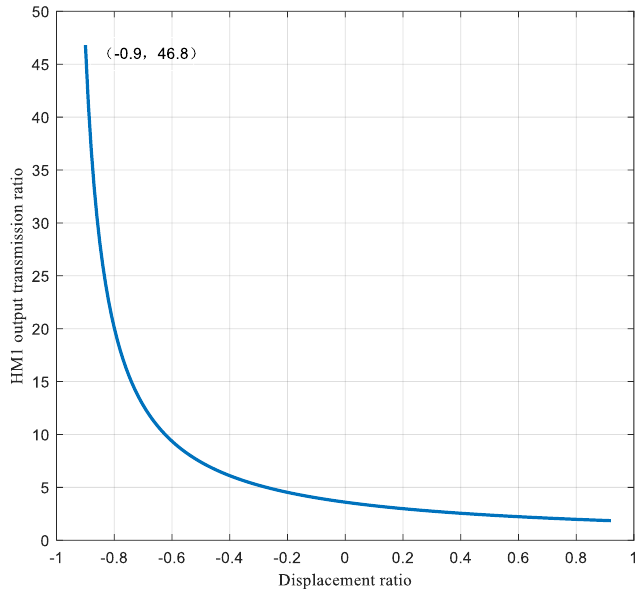
Figure 4. Transmission ratio output characteristics of HM1 section.